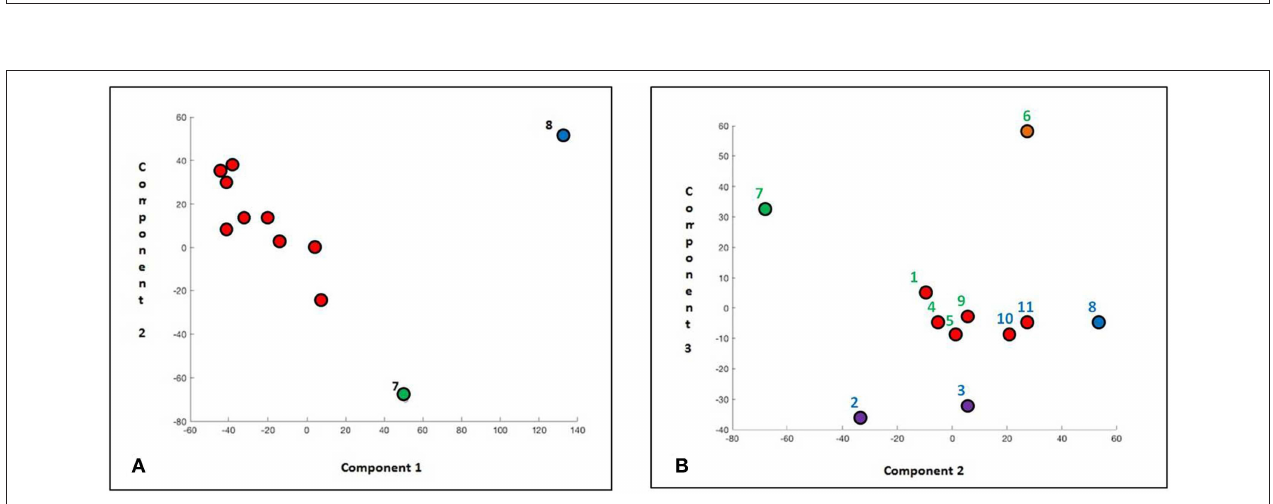
FIGURE 6 | PCA 2D scatter plot of scored genes without largest fold-change. (A) Scatter plot on component 1 and 2. (B) Scatter plot on component 2 and 3.